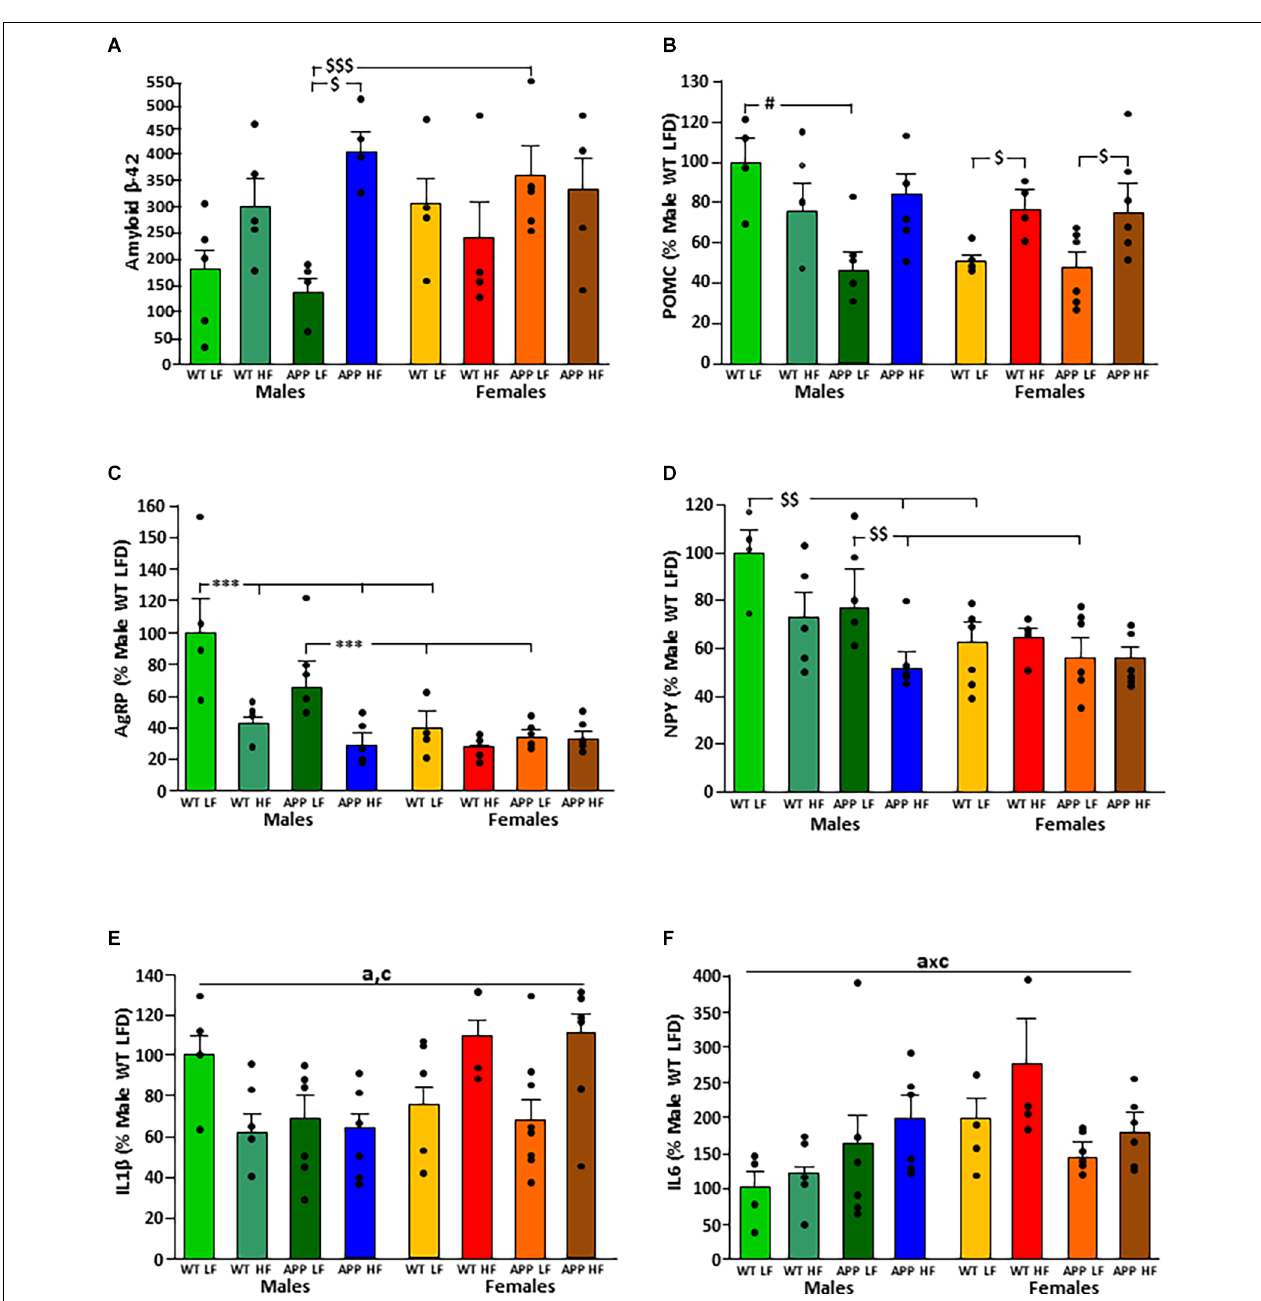
FIGURE 6 | Levels of amyloid β -42 (A) and relative mRNA levels of proopiomelanocortin (POMC; B ), Agouti related peptide (AgRP; C ), neuropeptide Y (NPY; D ), interleukin (IL; E ) 1 β and IL6 (F) in the hypothalamus of male and female mice after being exposed to a low fat (LF) or high fat (HF) diet. WT, wild type; APP, transgenic for amyloid precursor protein. ∗ = p < 0.0001; $ = p < 0.05; $$ = p < 0.005; $$$ = p < 0.0005; # = p < 0.02. Bar graphs represent the mean ± SEM of 4–5 mice per experimental group. a, overall effect of genotype; c, overall effect of